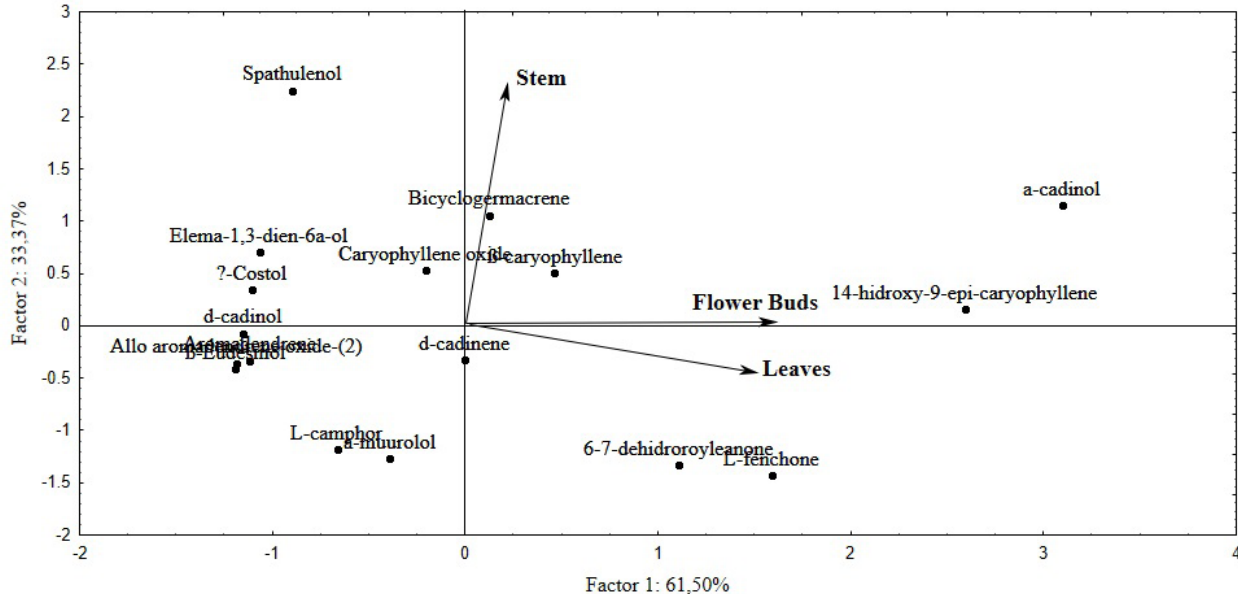
FIGURE 2 - Biplot of principal component analysis scores and loadings for the gas chromatography and mass spectrometry representing the projection of Tetradenia riparia leaves, flower buds, and stem essential